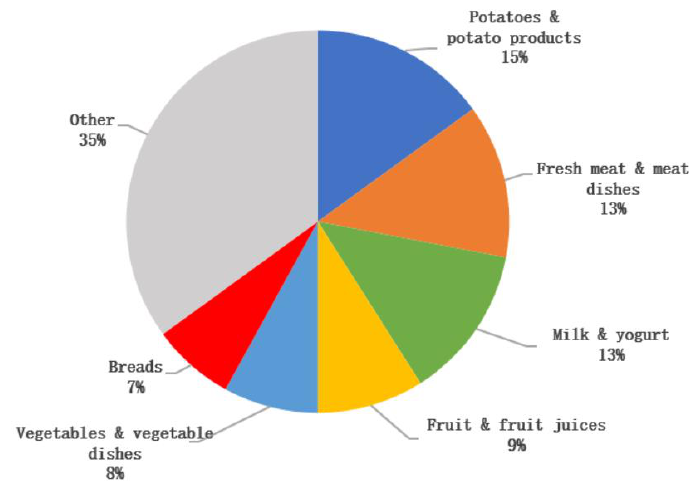
Figure 2. Key sources of potassium intake in Irish adults.